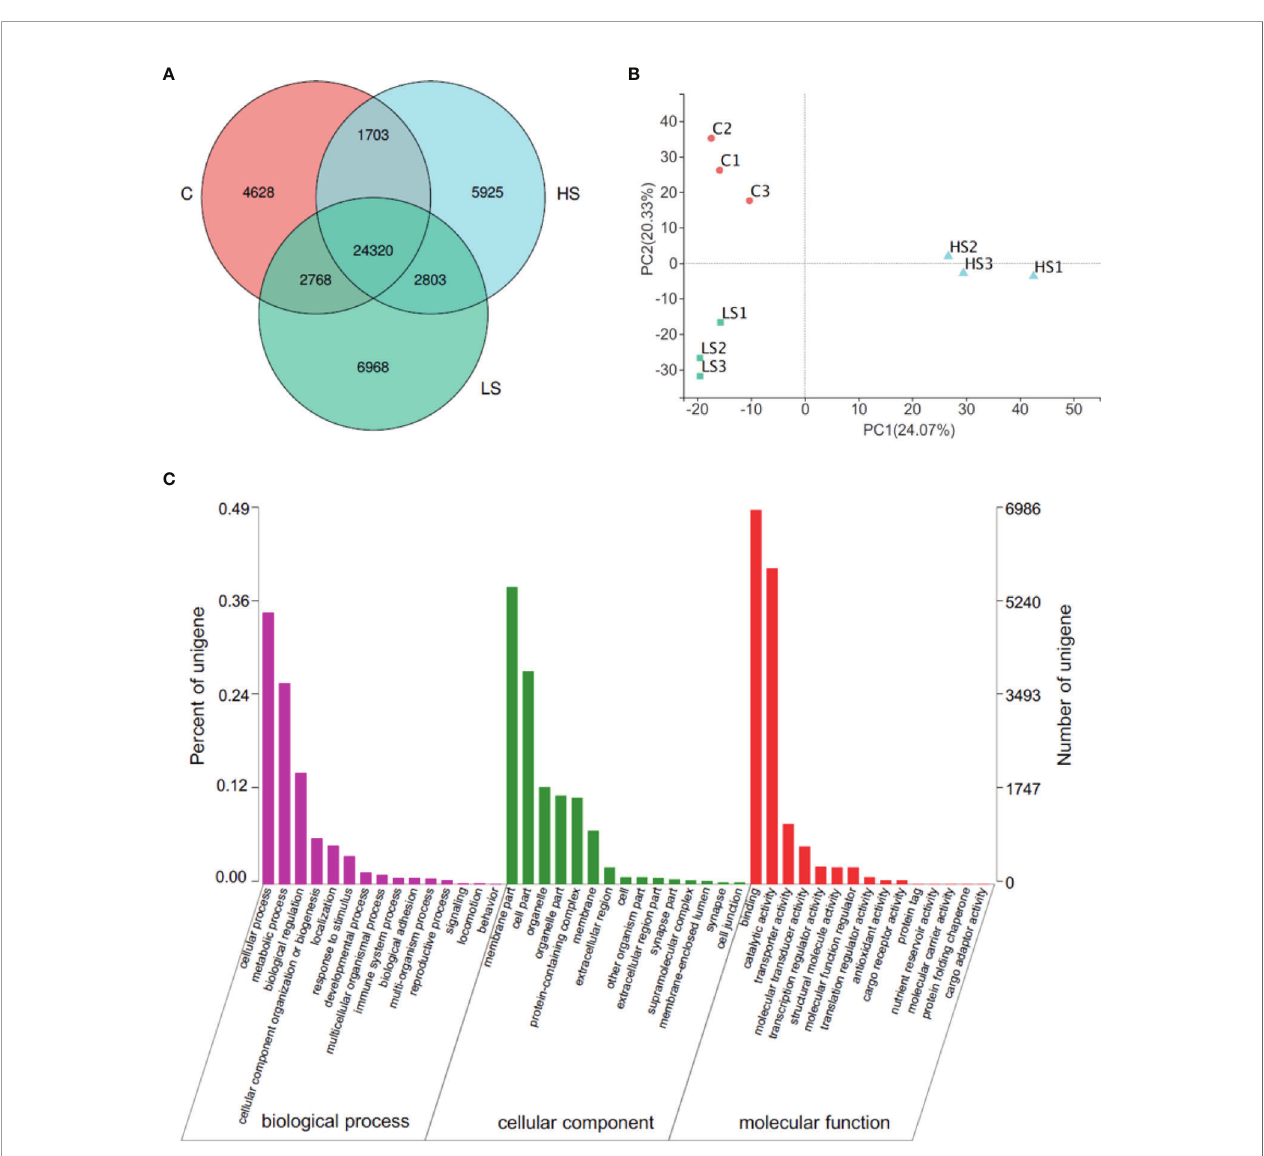
FIGURE 2 | Transcriptome expression analysis and functional annotation of the Pinctada maxima gill. (A) Venn diagram between groups, (B) principal components analysis (PCA) of expression levels between samples, (C) Gene Ontology (GO) categorization of the unigenes in the gill transcriptome of Pinctada maxima . C, control group; HS, high salinity group; LS, low salinity